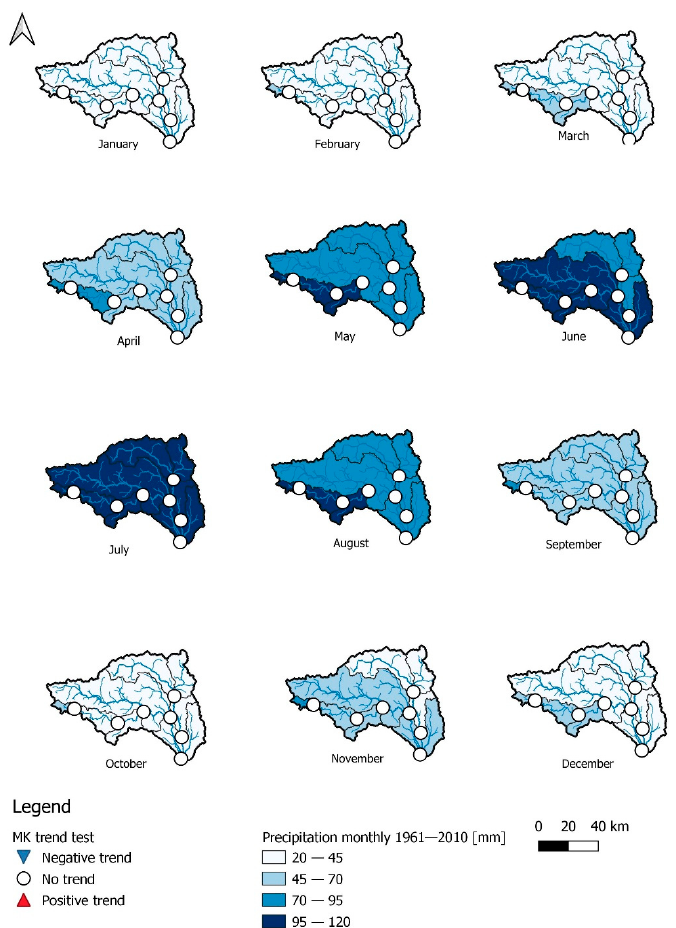
Figure 6. Monthly trends in the precipitation during the years 1961–2010.